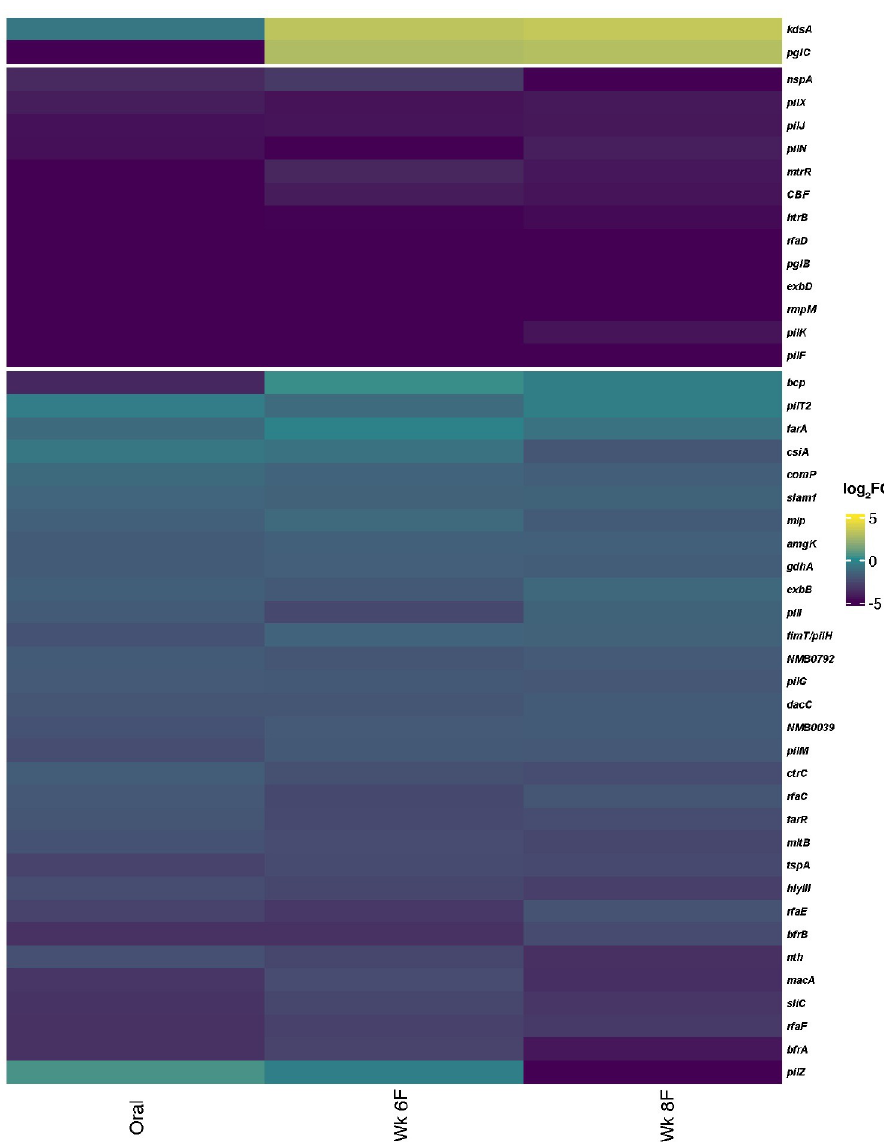
Fig 4. Homologs of human adapted Neisseria host interaction factors are required for N . musculi survival in mice. Relative abundance of N . musculi homologs of Neisseria host interaction factors identified in the in vivo screen. Heatmap depicts ORF Tn5 directed log 2 fold change vs inoculum in N . musculi oral and gut samples. Genes are grouped by k-means clustering after calculation of Euclidian distances by complexHeatmap suite default settings. Correlation of gene name to N . musculi locus tag, protein similarity to human adapted Neisseria , and fold change data is found in S3 Data. (54.5% identity over 400 amino acids). While gluP has been identified as differentially expressed in N . meningitidis in vitro infection studies, its exact contribution to persistent car- riage remains unknown in this context [44,82]. B . abortus gluP is essential for glucose uptake in host environments, as mutants display reduced survival in alternatively activated macro- phages and cannot persist in a chronic mouse infection model [83,84]. These observations sug- gests that N . musculi gluP and cstA may function in a similar manner to allow long-term colonization.